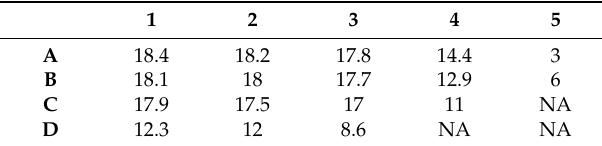
Table 1. Signal to Noise Ratio (SNR) (dB) related to raw data captured by step heating thermography (heating period). 1 Table 2. SNR related to raw data captured by step heating thermography (cooling period).